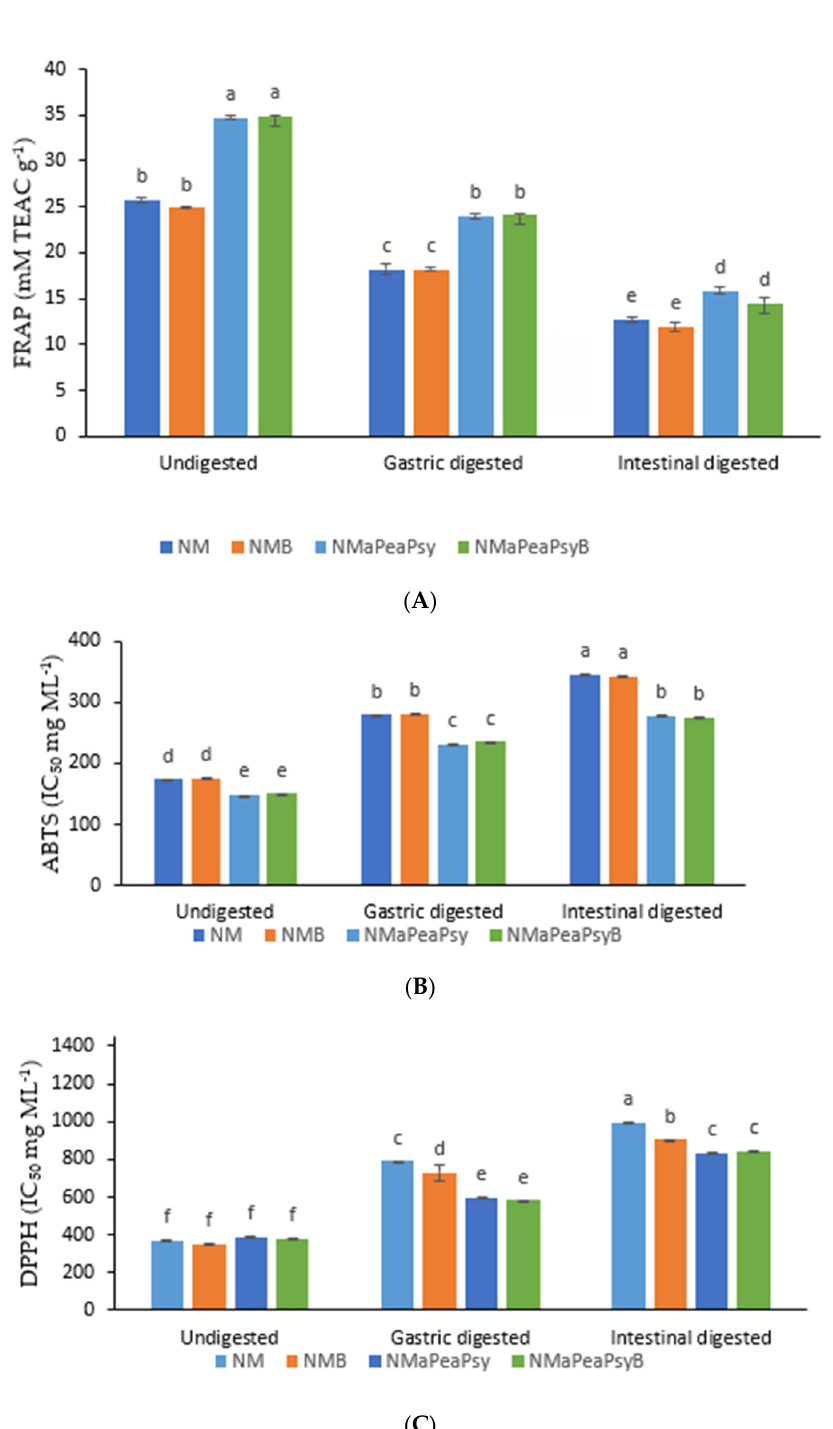
Figure 4. Effect of co-encapsulation of Natal plum ( Carissa macrocarpa ) juice on FRAP ( A ), ABTS ( B ) and DPPH ( C ) scavenging activity. Error bars show the standard deviation value, bars with different letters are significantly different p < 0.05. Key: NM: Natal plum ( Carissa macrocarpa ) juice; NMB: Natal plum ( Carissa macrocarpa ) juice + Ltp. plantarum 75 ; NMaPsy: Natal plum ( Carissa macrocarpa ) juice + maltodextrin + psyllium mucilage; NMaPsyB: Natal plum ( Carissa macrocarpa ) juice + maltodextrin + psyllium mucilage + Ltp. plantarum 75 ; NMaPeaPsy: Natal plum ( Carissa macrocarpa ) juice + maltodextrin + pea protein isolate + psyllium mucilage; NMaPeaPsyB: Natal plum ( Carissa macrocarpa ) juice + maltodextrin + pea protein isolate + psyllium mucilage + Ltp. plantarum 75